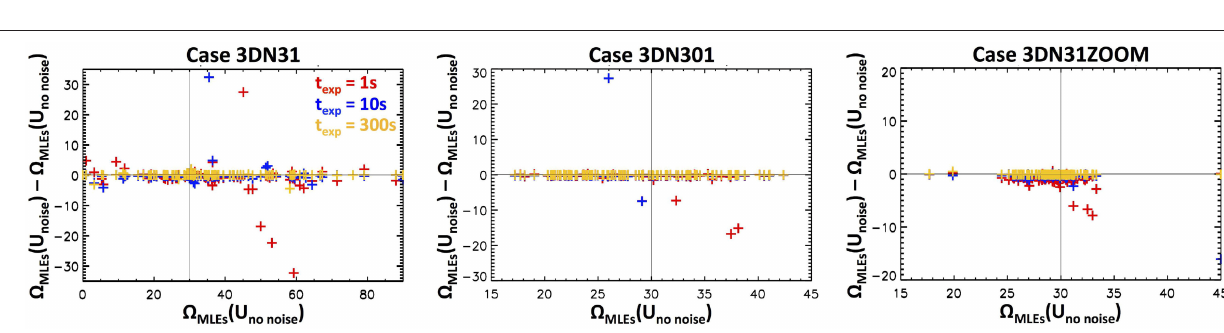
The plots are only shown for the (cid:127) parameter because all three parameters θ , φ , and (cid:127) display very similar results. In Figure 11 , one can see a nearly perfect horizontal line at y = 0 for (cid:127) MLEs obtained with an exposure time of 300 s (yellow crosses) for all test cases (3DN31, 3DN301, and 3DN31ZOOM). This means that the t exp = 300 s case is equivalent to the no-noise case. For cases t exp = 10 and t exp = 1 s, the plots show some departure from the y = 0 line, which increases with the level of noise. The figure also shows that the noise effect on the robustness of the MLEs depends affected by the noise while 3DN31ZOOM is the least